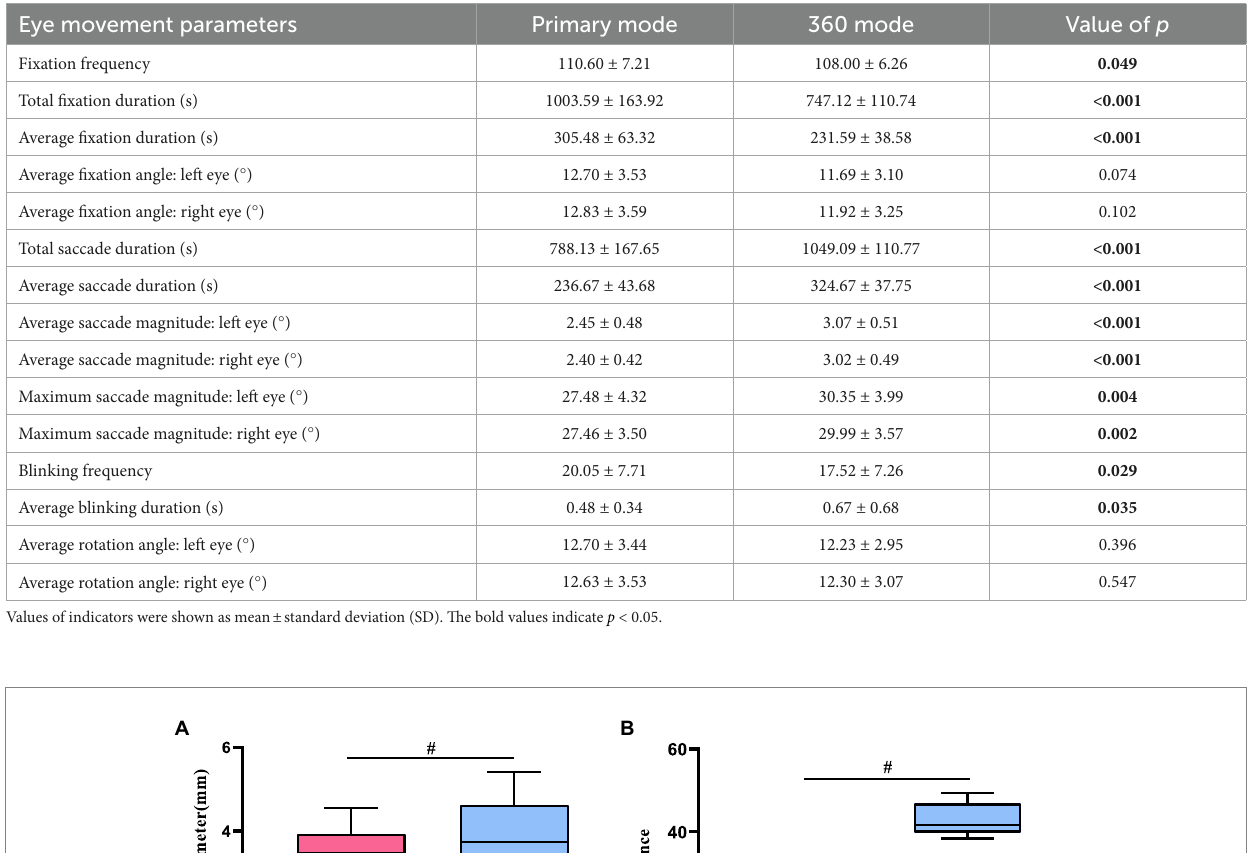
TABLE 1 Primary mode and 360 mode eye movement features